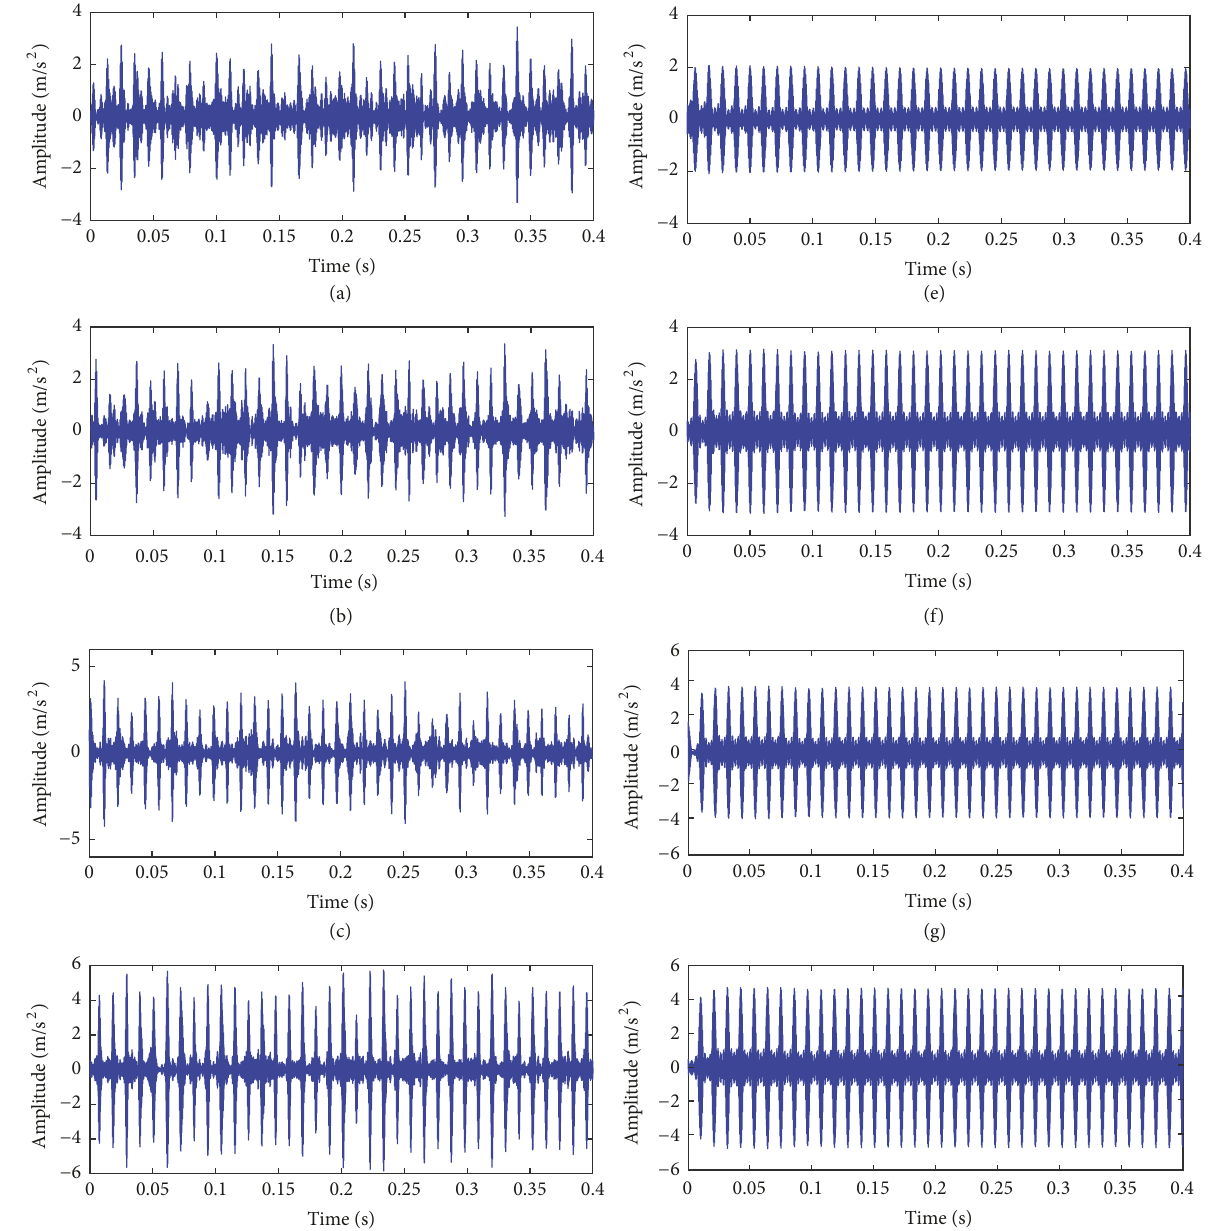
Figure 10: Vibration responses of the experimental signals and the numerical signals under different loads. Experimental signals: (a) 4.9 N, (b) 9.8 N, (c) 14.7 N, and (d) 19.6 N. Numerical signals: (e) 4.9 N, (f) 9.8 N, (g) 14.7N, and (h) 19.6 N.